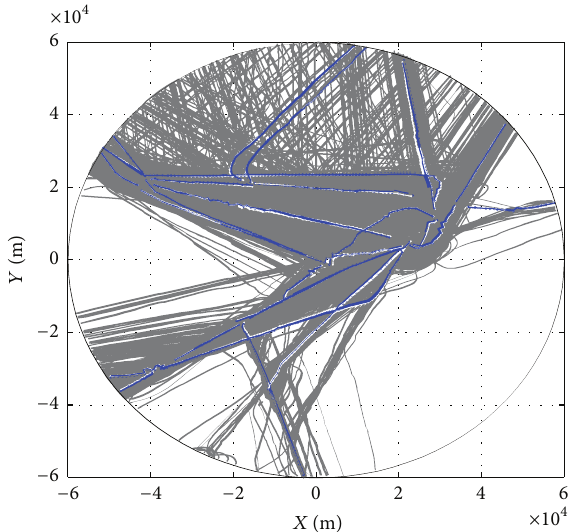
Figure 7: Clustering results for departure trajectories are represented by blue lines. The radar trajectories are marked with grey lines.